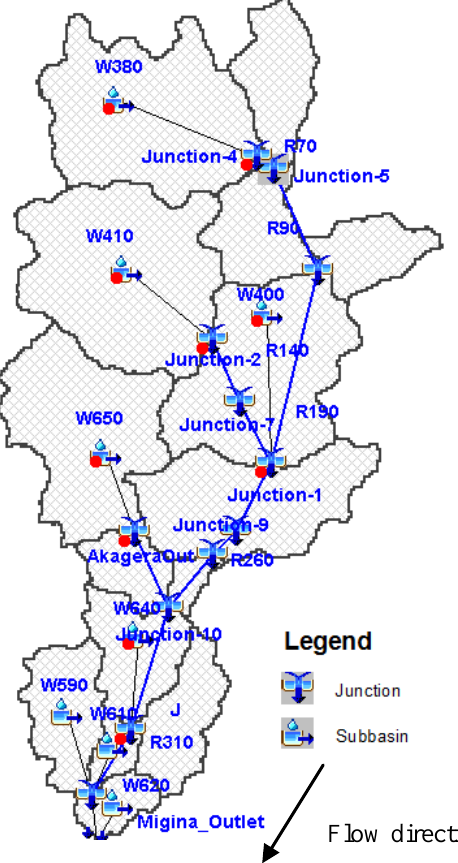
Figure 2 Migina catchment model set up in HEC-HMS. Figure 2. Migina Catchment model set-up in